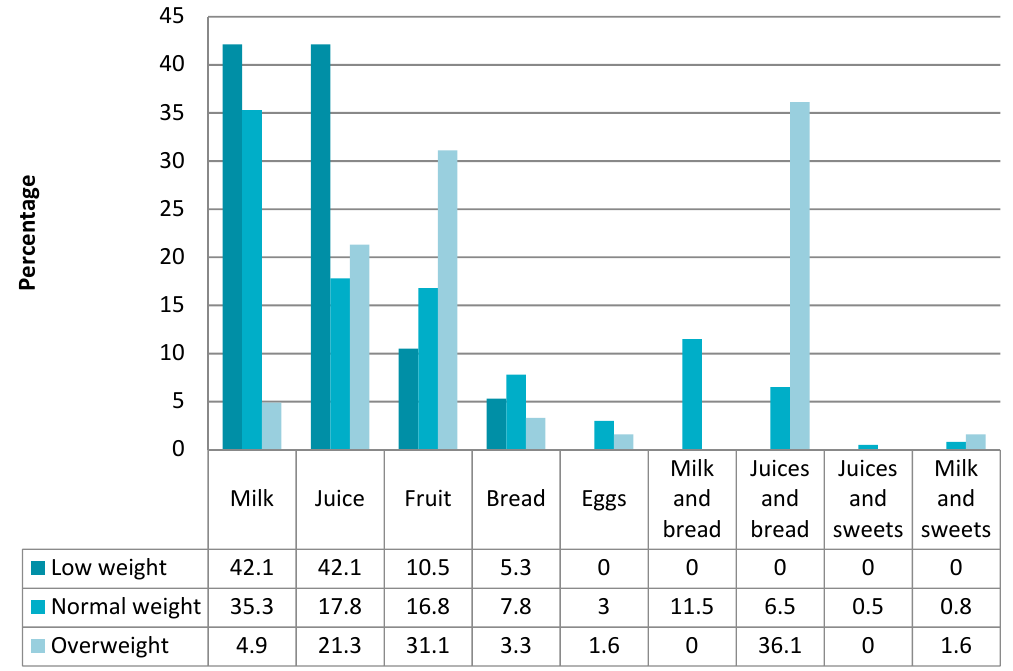
Figure 5. Food consumption at breakfast according to BMI after the intervention.